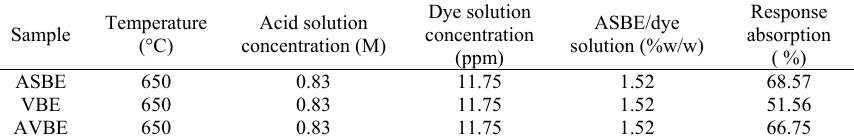
Table 4: Dye adsorption by ASBE, VBE and AVBE in optimal conditions